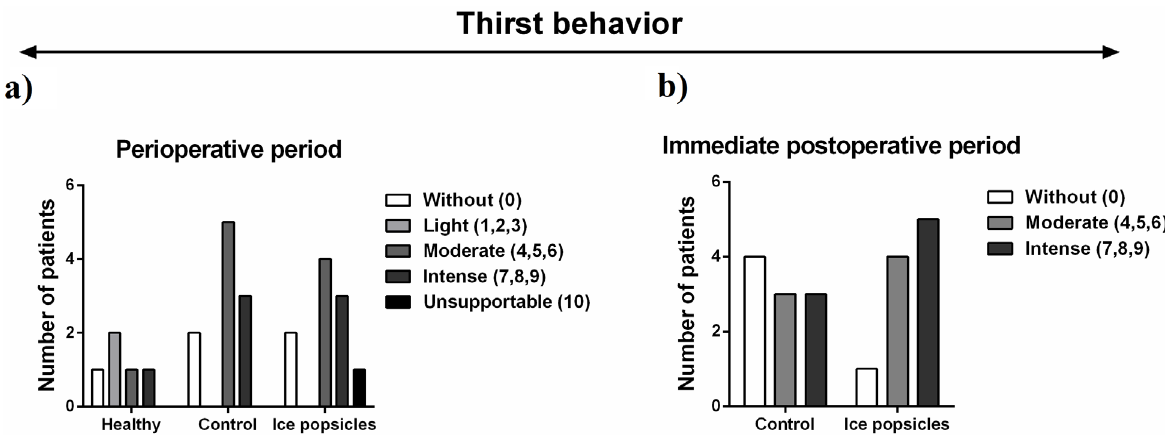
Figure 4. Evaluation of thirst behavior in the comparison between before and after the surgery procedure. Herein, we demonstrated through numerical verbal scale (NVS) the intensity of thirst in the healthy, control, and treated group in the (a) preoperative and (b) immediate postoperative period. Data are shown as the mean of five different measurements ± SD. The statistical analyses were made using column statistics.